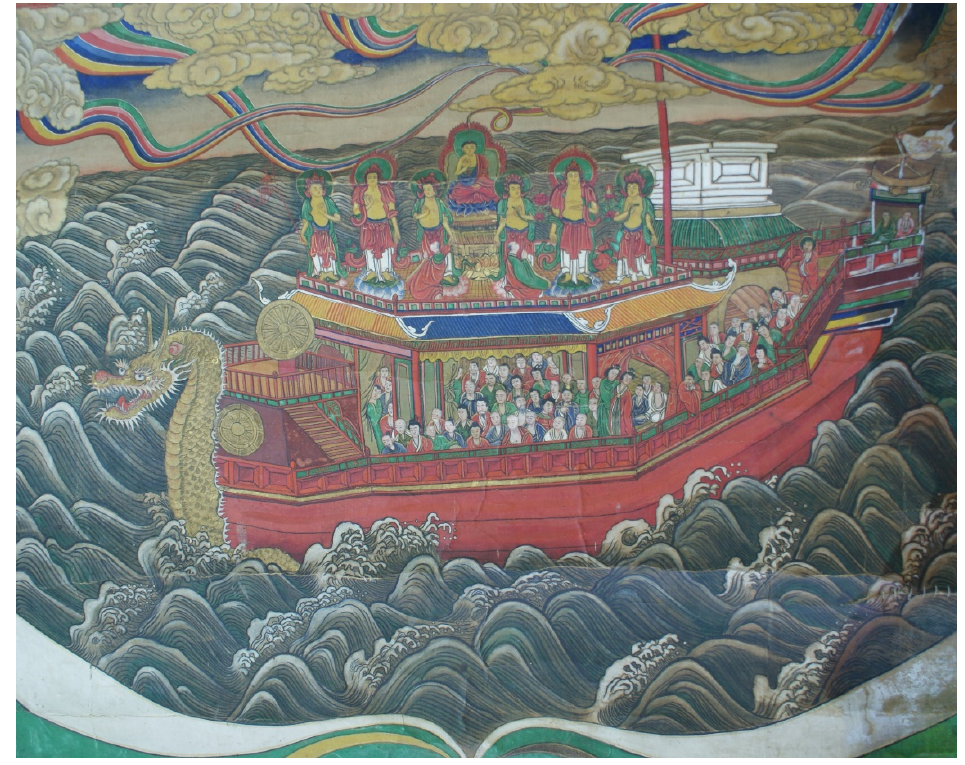
Figure 11. Detail of Three Gates in a Single Mind showing the salvific dragon boat in the central frame. Photograph by Choi Yeub.